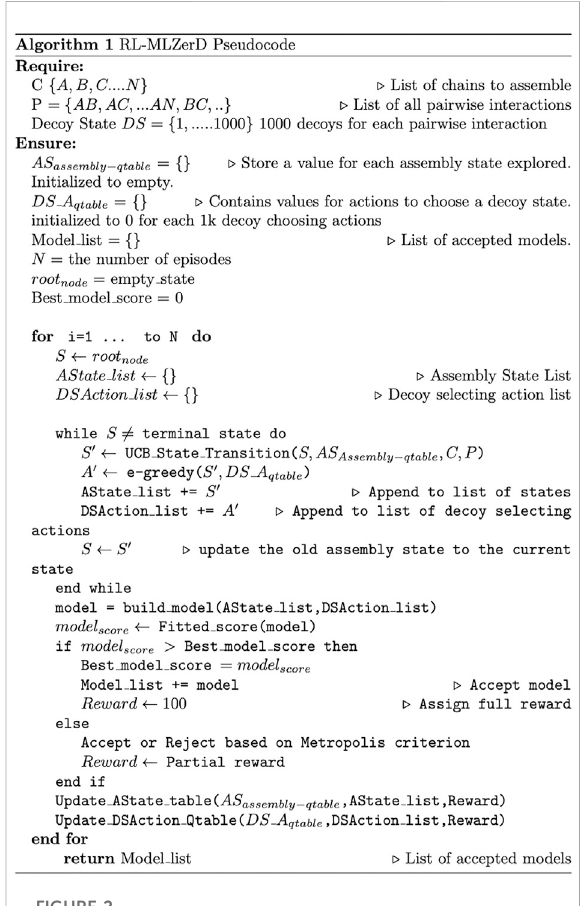
FIGURE 2 Pseudocode of RL-MLZerD. For each episode, AState_list representstheassemblestatevisitedfortheepisode, DSAction_list represents the selected actions (decoys) for each decoy state. The build_model function takes the AState_list and DSAction_list and returns the assembled model. Fitted_score computes a score of a model. Update_state_table updates the state value estimate for the assemble state that participated in building the model, update_action_qtable uses the Bellman Fold equation to update the decoy state actions value estimate that participated in the model